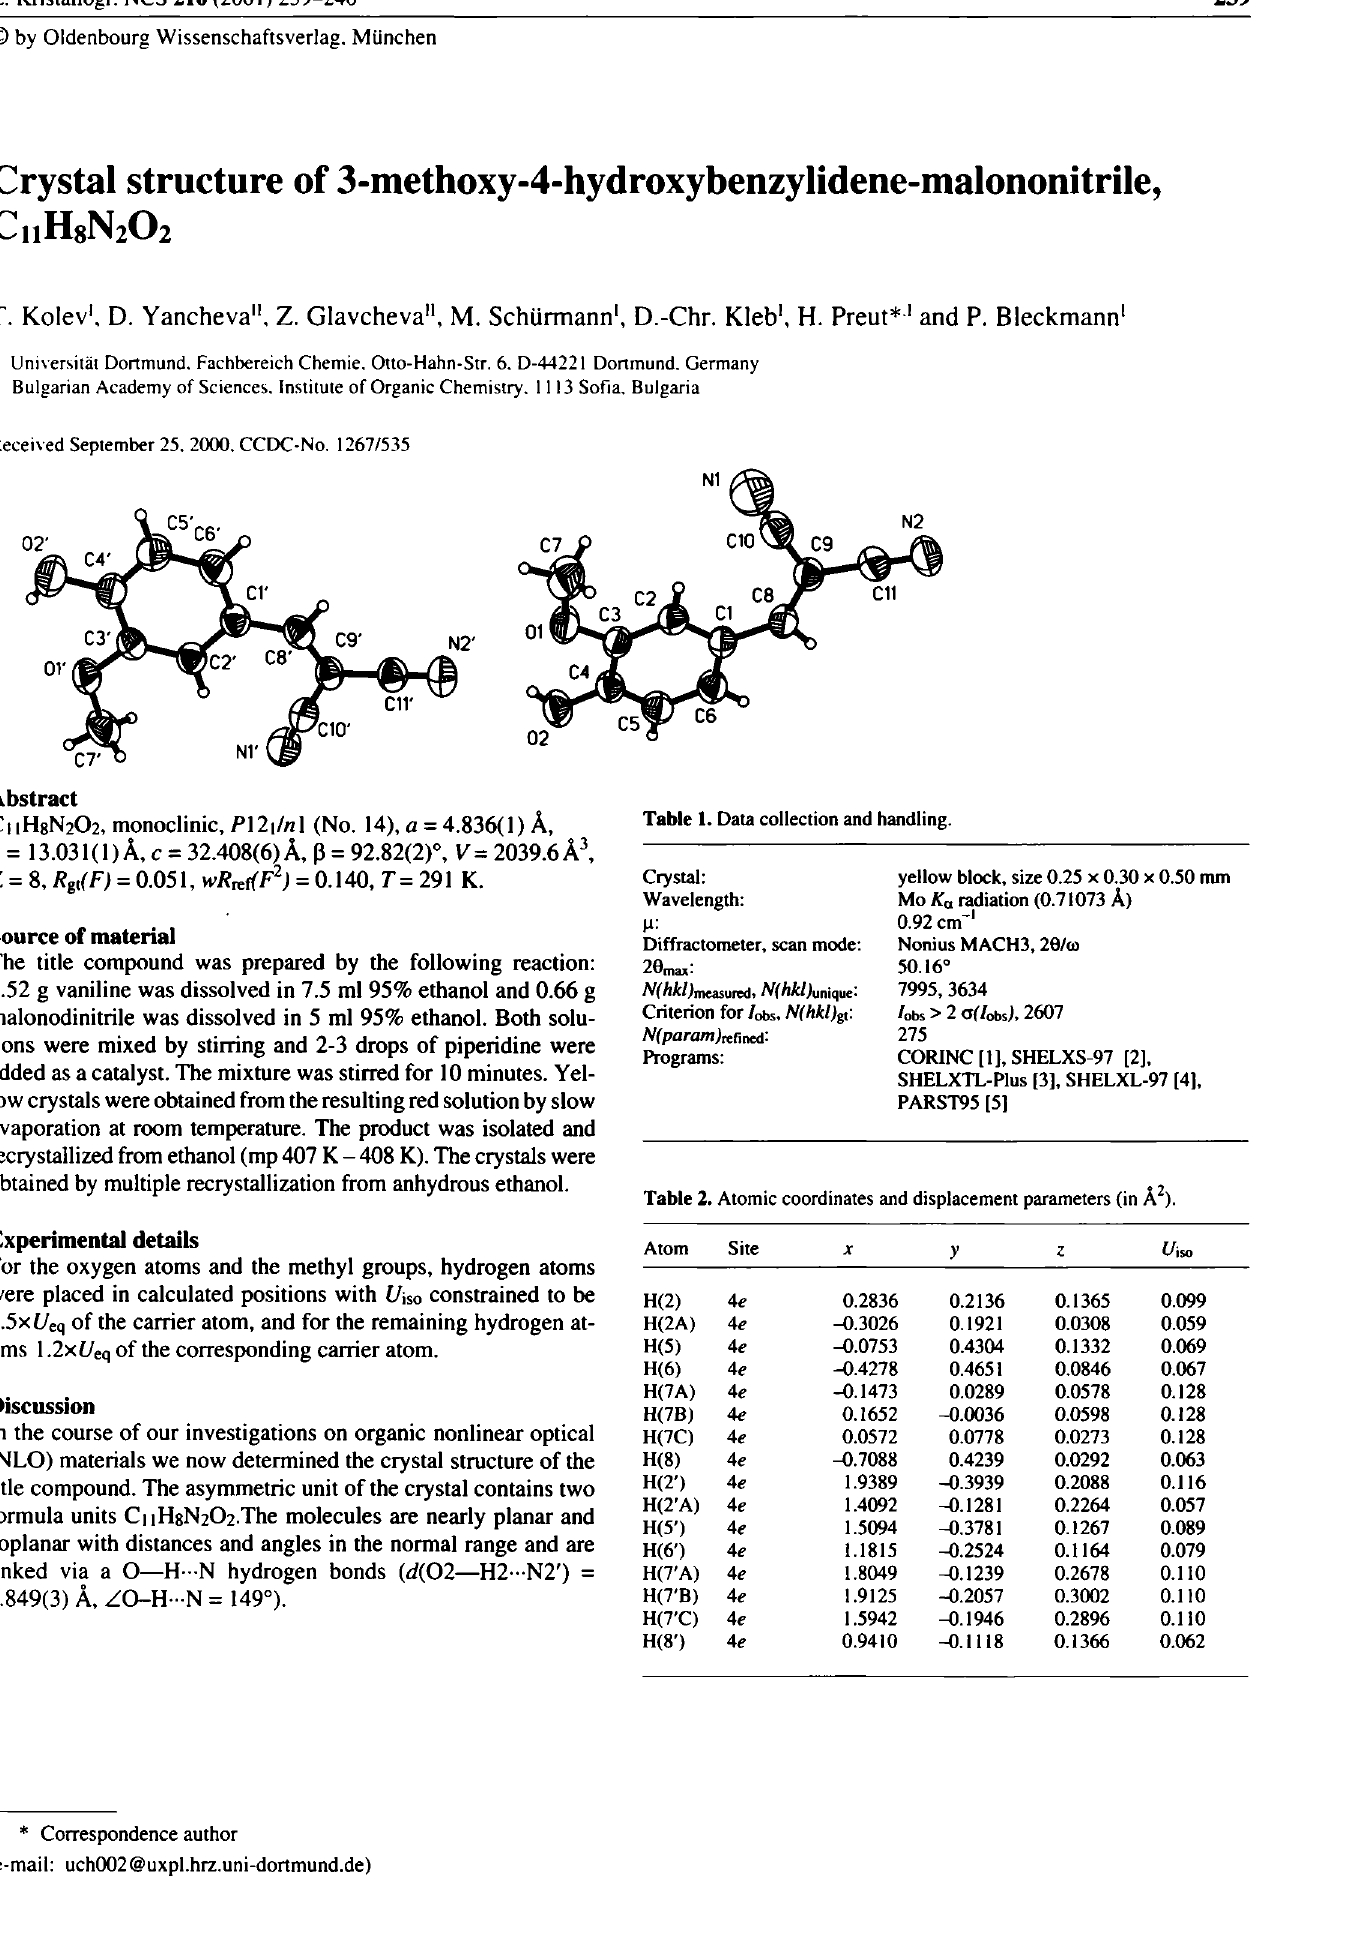
Table 2. Atomic coordinates and displacement parameters (in A 2